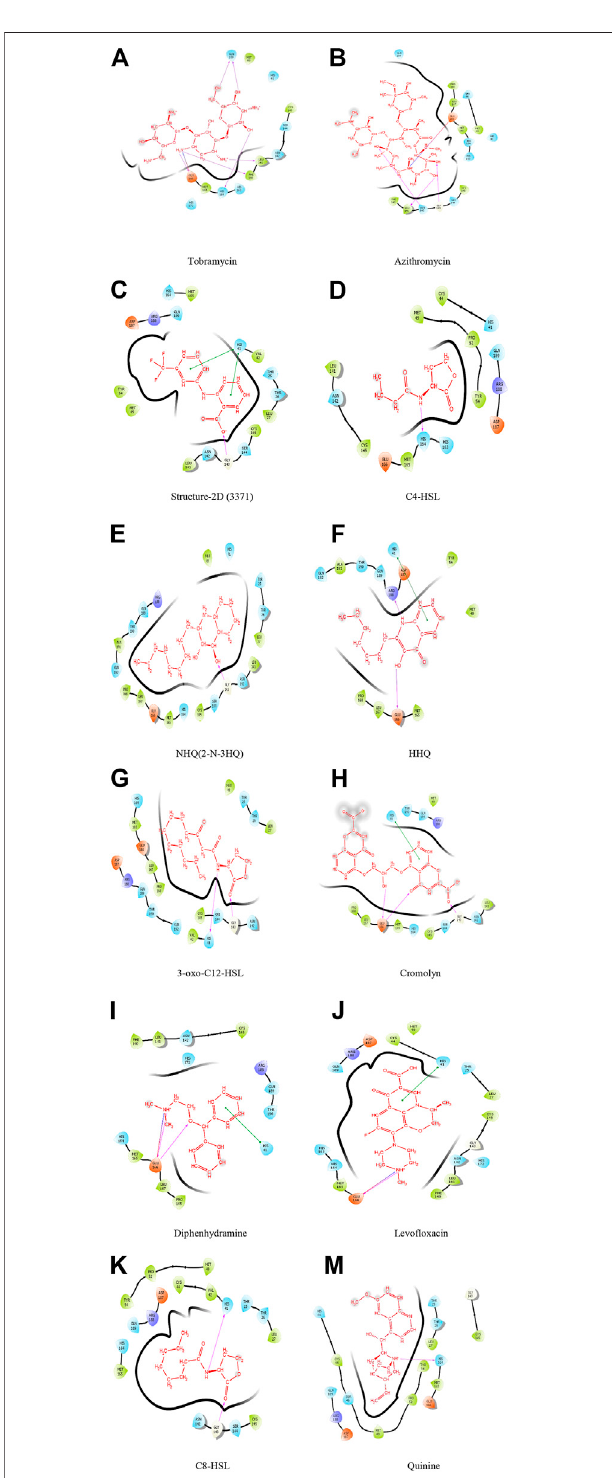
FIGURE 2 | Molecular interaction of ligands with